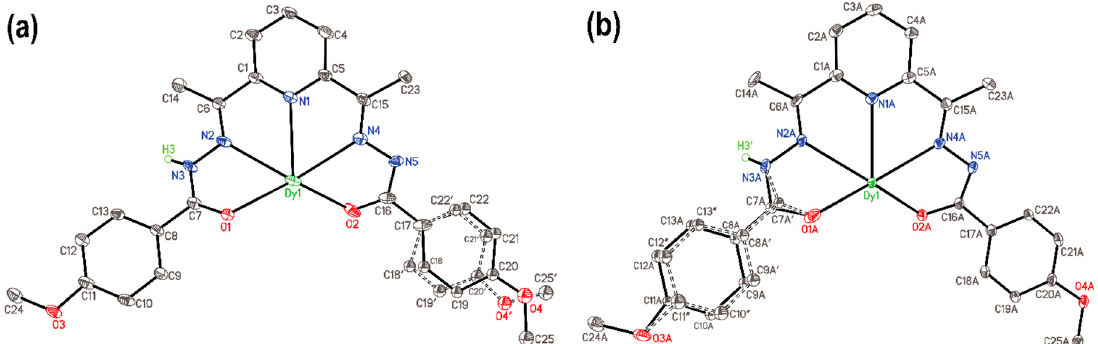
Figure 5. Labeling scheme for main molecule of 2-Dy . On each part of the image ( a , b ) one ligand, and hydrogen atoms (except one remaining hydrogen atom of a monoanionic ligand) are not shown for clarity; both hydrogen atoms positions H3 and H3 ′ were occupied at the 50% probability level. Disordering in each ligand is shown with dashed open bonds.